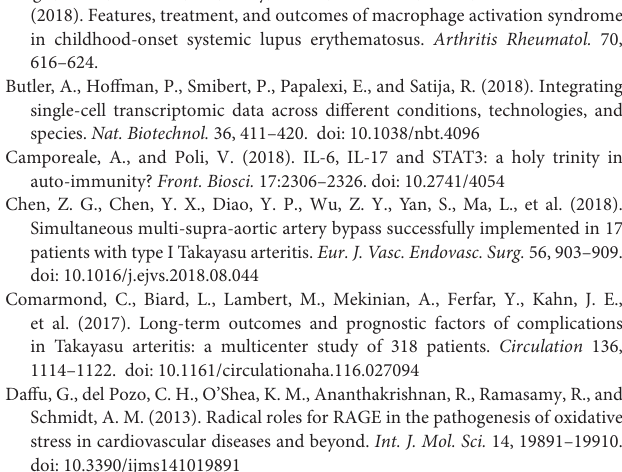
Supplementary Table 1 | Clinical information for the peripheral blood mononuclear cells. Supplementary Table 2 | Cell markers for all cell clusters. Supplementary Table 3 | Cell markers for CD8+ T/NK cells. Supplementary Table 4 | Cell markers for CD4+ T cells. Supplementary Table 5 | DEGs for all cell